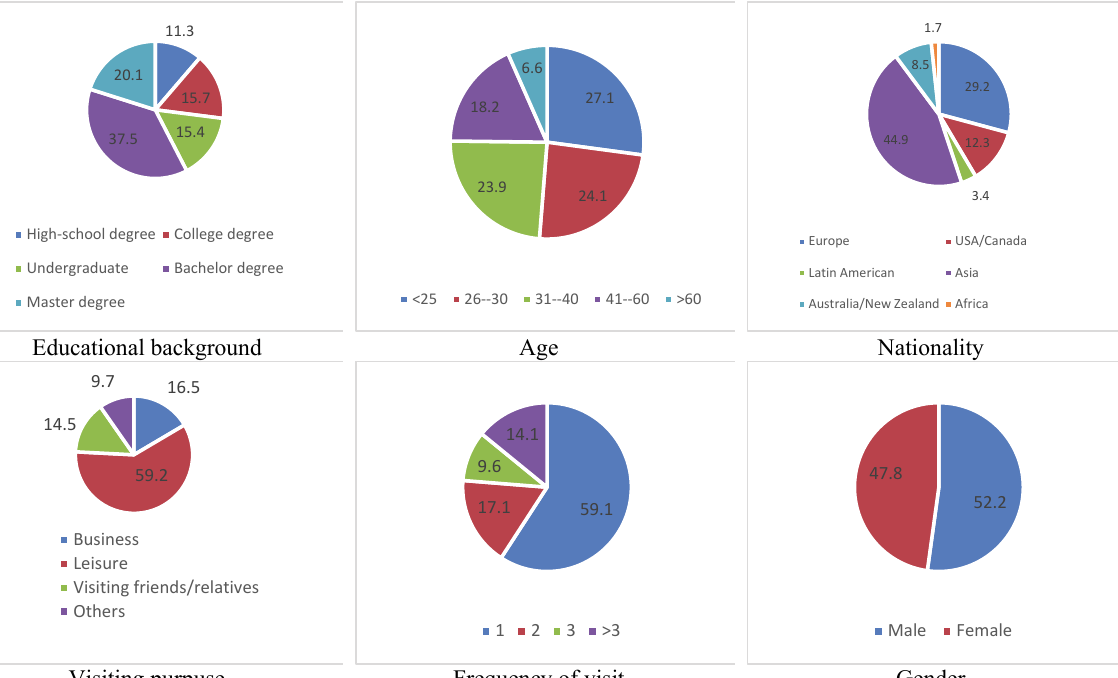
Fig. 1. Personal characteristics of the